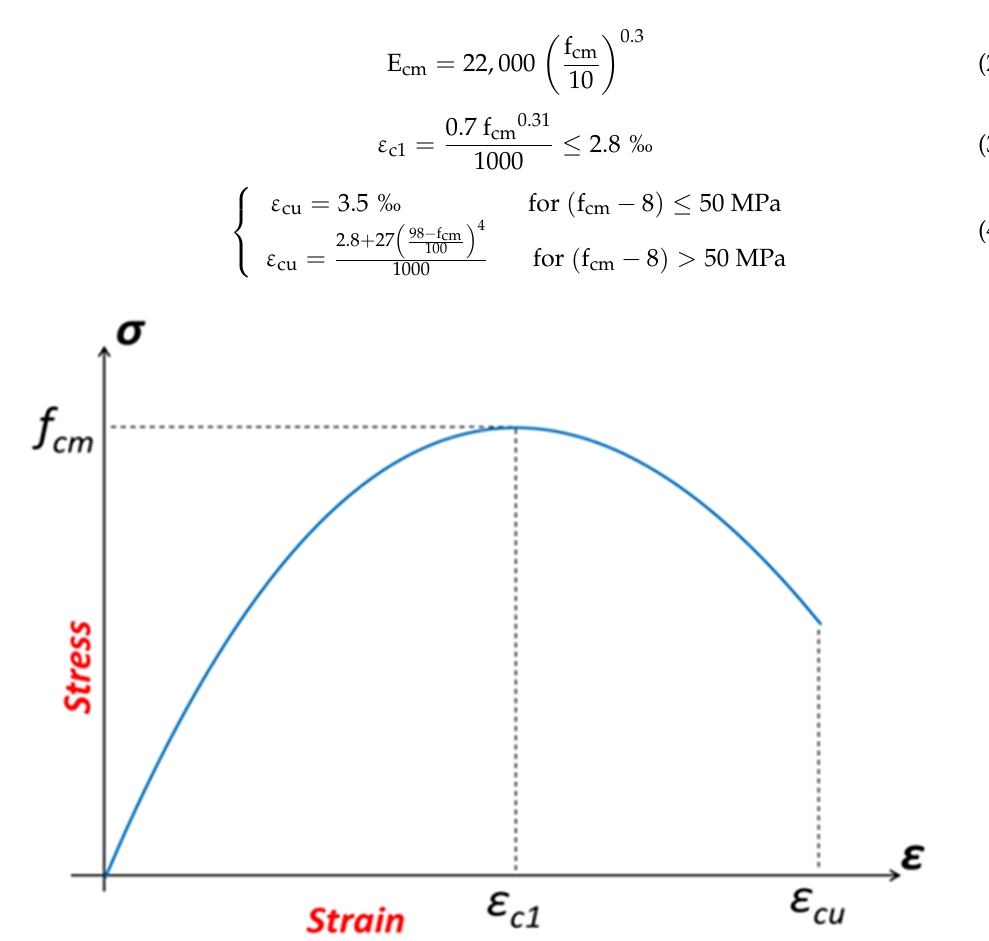
Figure 1. The adopted behavior of concrete in compression [14].